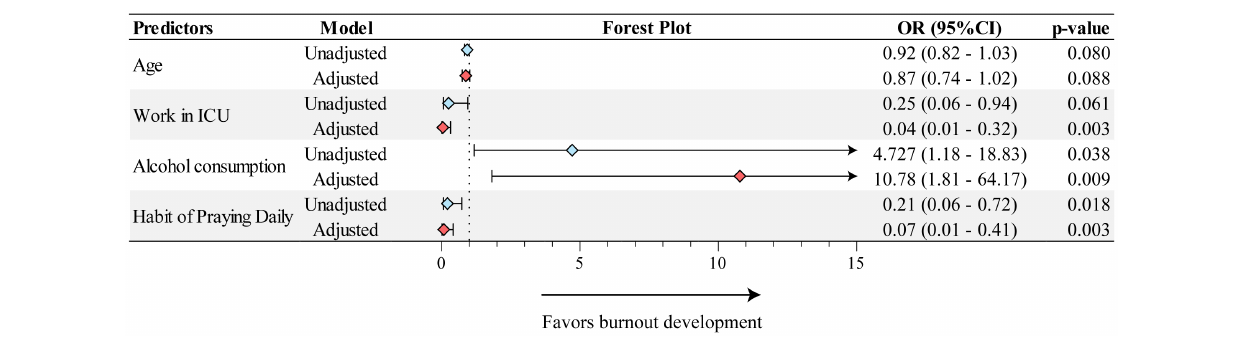
FIGURE 4 Adjusted and unadjusted binary regression model for Burnout development. The model presents only the variables which passed on the final step of the regression analysis. Multivariable regression was adjusted for differences in values characteristics with statistical relevance (value of p < 0.1). Odds Ratio (OR); Intensive Care Unit